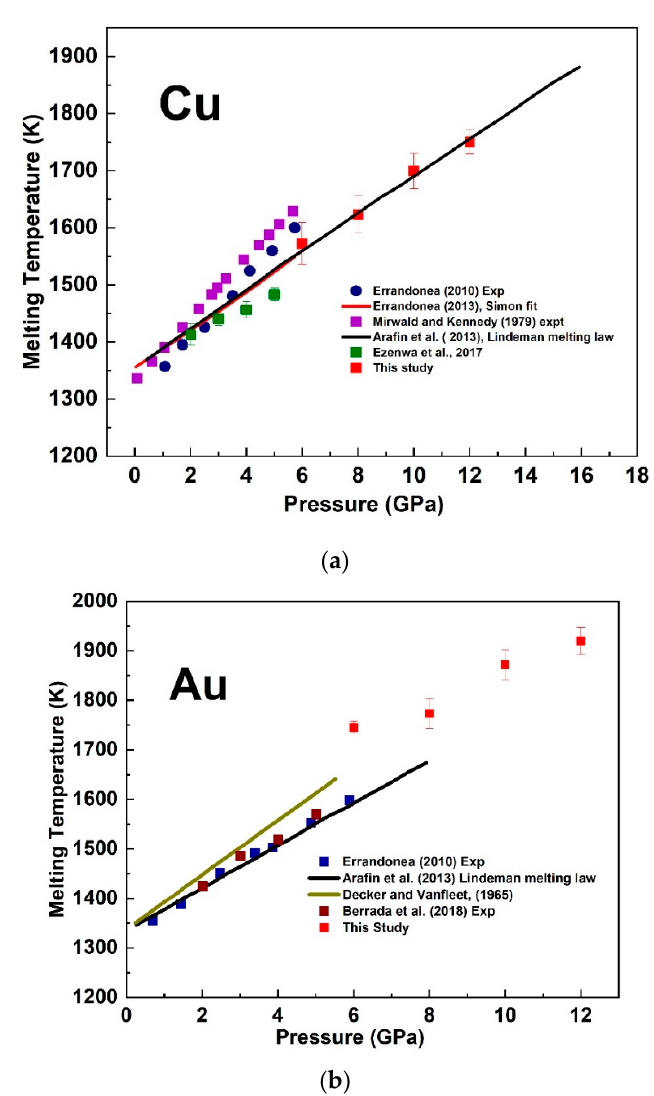
Figure 8. Melting temperature of Cu ( a ) and Au ( b ) as a function of pressure compared with previous studies. The melting temperature at fixed pressure was taken as the recorded temperature at the onset of melting.